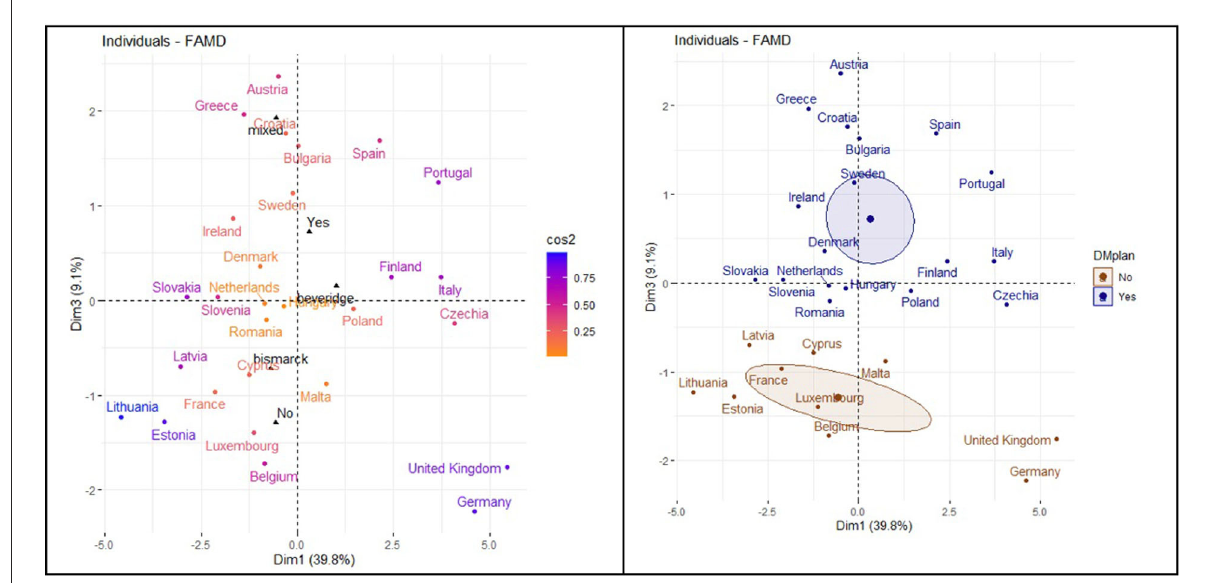
FIGURE10 Distribution of the countries and dimension 1 and dimension 3.